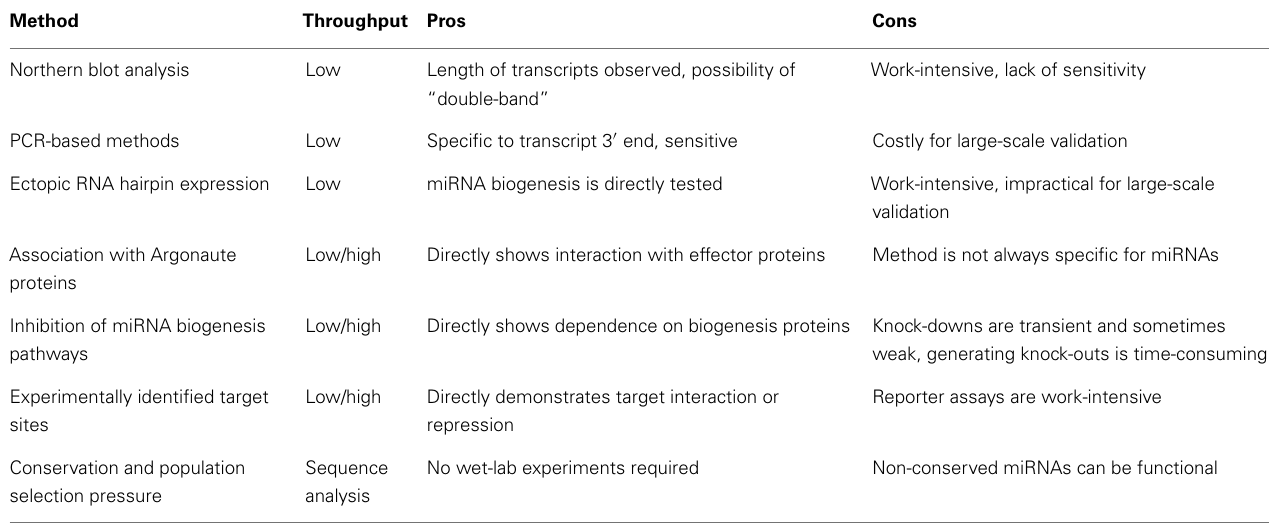
Table 2 | Methods for miRNA validation